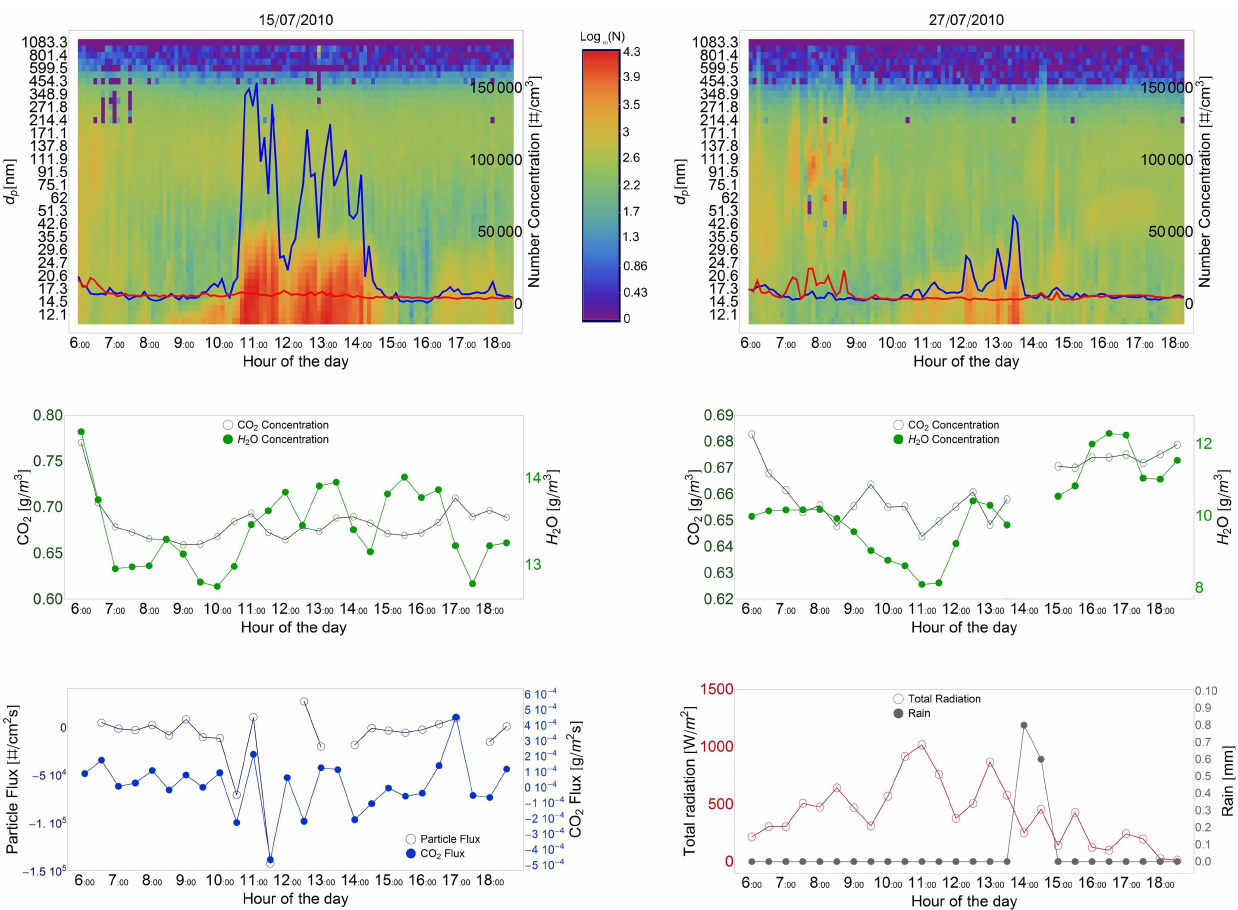
(blue) and N concentrations (red). CO 2 p > 50 and F fluxes are shown for N C